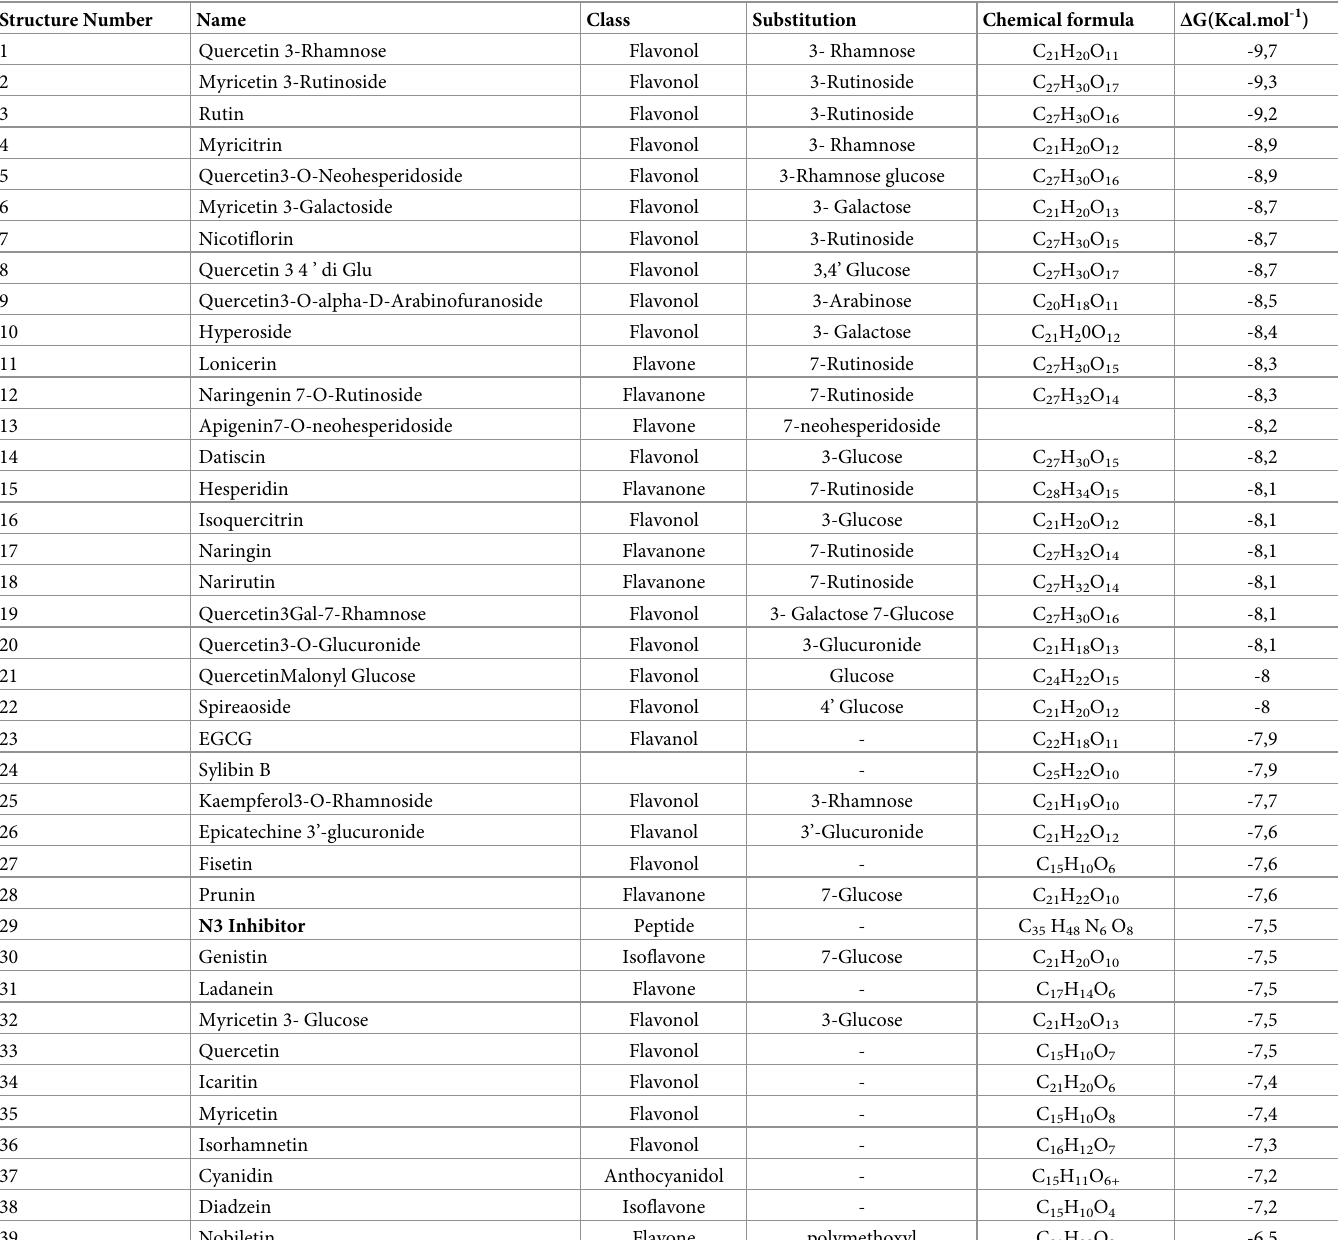
Table 1. Binding energies of flavonoids docked against main protease. Structure